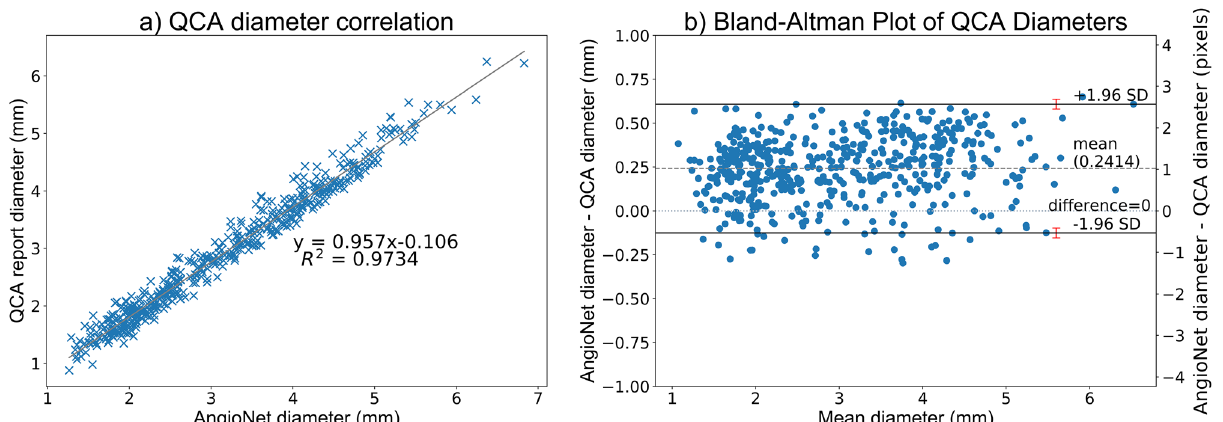
Figure 7. ( A ) Correlation plot of QCA and AngioNet derived vessel diameters. ( B ) The Bland–Altman plot demonstrates that AngioNet’s segmentation and QCA are interchangeable methods to determine vessel diameter since more than 95% of points lie within the limits of agreement. The red error bars represent the 95% confidence interval containing the limits of agreement. The mean difference in diameter between methods is 0.24 mm or 1.1